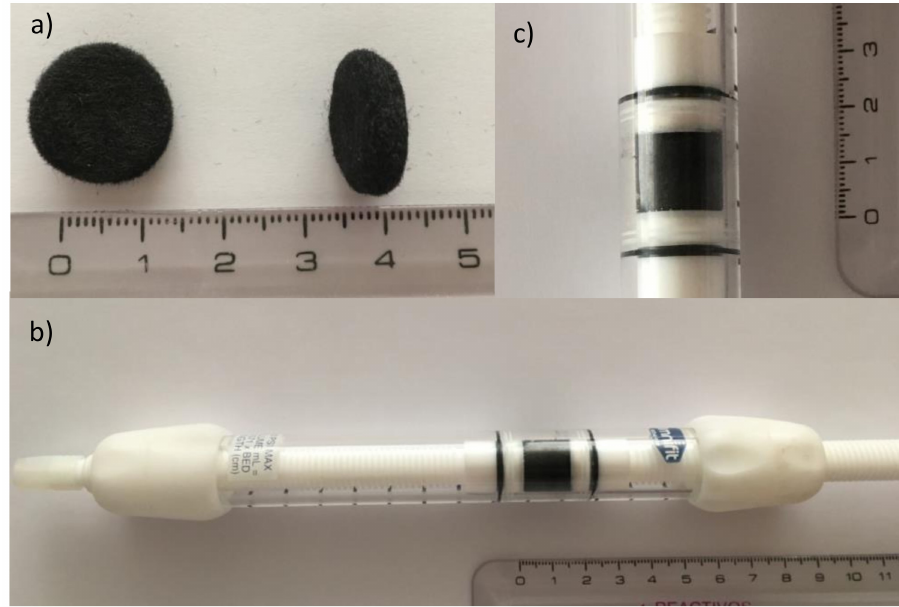
Figure 7. Disks of SHTC@GF ( a ) reactor with three tightly piled disks ( b ) and enlarged image of the piled disks ( c